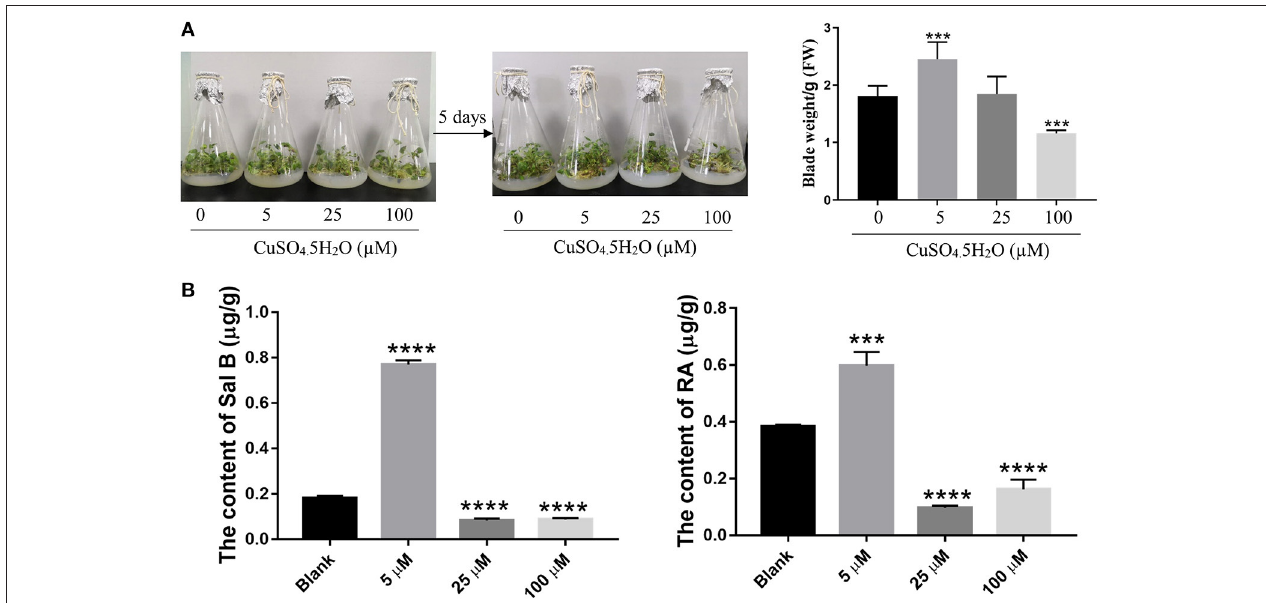
FIGURE 1 | Effect of copper ion treatment on the growth of Salvia miltiorrhiza and biosynthesis of salvinolic acids (SalAs). Two-month-old S. miltiorrhiza was treated with different concentrations of CuSO 4 .5H 2 O (0, 5, 25, and 100 µ M) for 5 days. (A) Phenotype change and weight change of S. miltiorrhiza were recorded before and after the treatment. (B) The content of salvianolic acid B and rosemarinic acid in untreated and treated S. miltiorrhiza using high-performance liquid chromatography (HPLC) with standards. Data represent the mean ± SD of three independent biological replicates. Significant differences between the treatment and control samples were determined using a Student’s T -test (*** P < 0.001 and **** P <